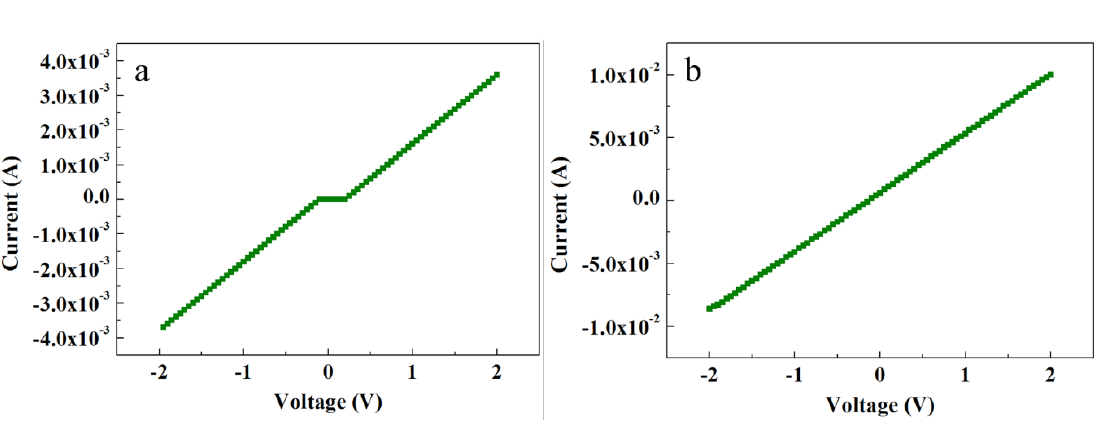
Figure 6. I-V characteristics of ( a ) OPT-ACG ZNRs and ( b ) MAG ZNRs.